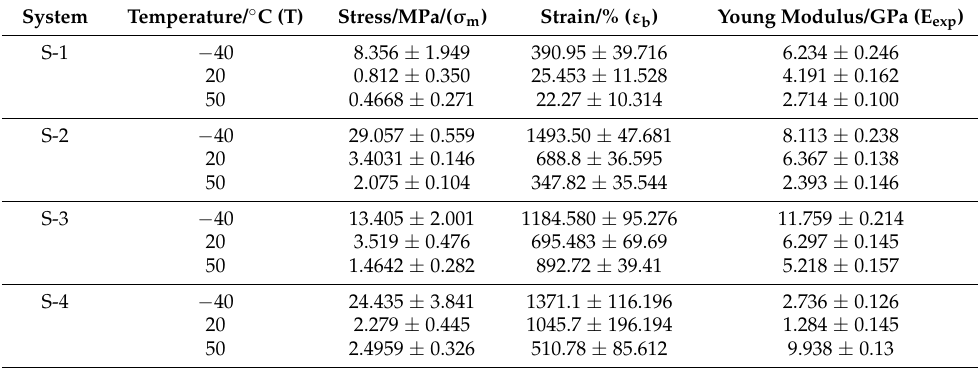
Table 4. The σ m , ε b, and E exp of the S-1, S-2, S-3, and S-4 binder systems.